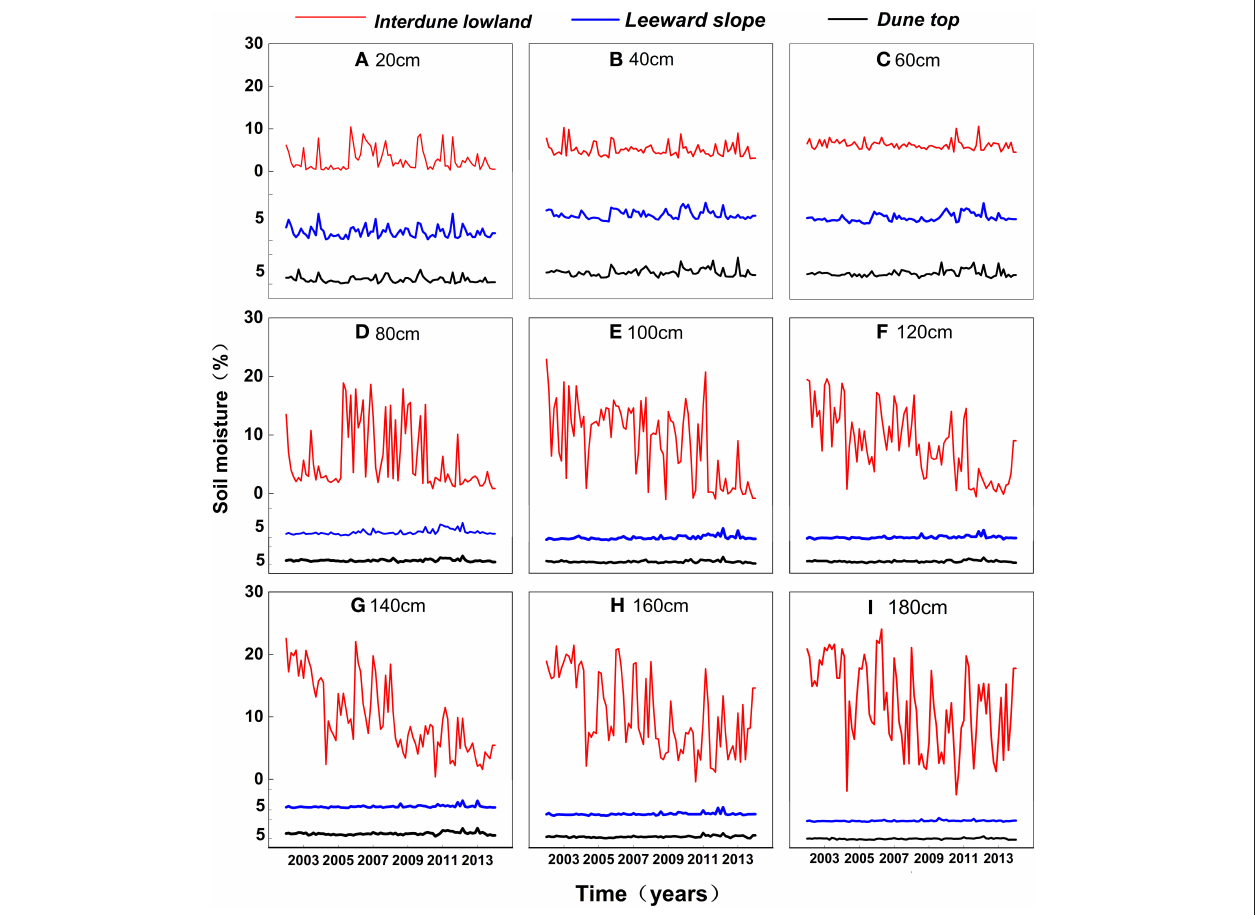
FIGURE 1 | The dynamics of soil water content of different soil layers at (A) 20cm, (B) 40cm, (C) 60cm, (D) 80cm, (E) 100cm, (F) 120cm, (G) 140cm, (H) 160cm, and (I) 180cm in